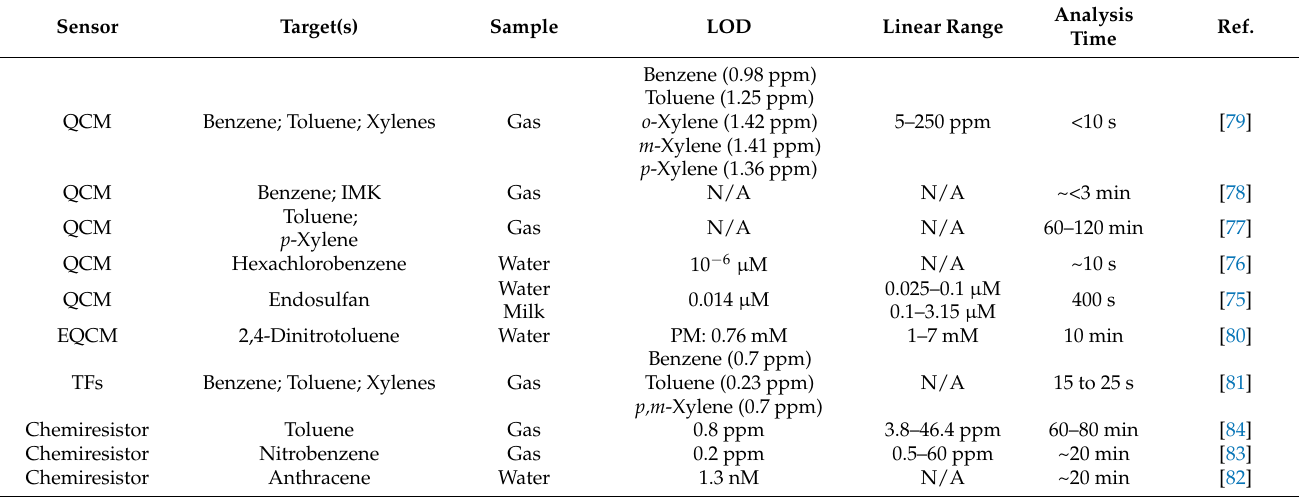
Table 3. Analytical characteristics of developed MIP-based mass and chemiresistive sensors for EPA Priority Pollutants. Sensor Target(s) Sample Linear